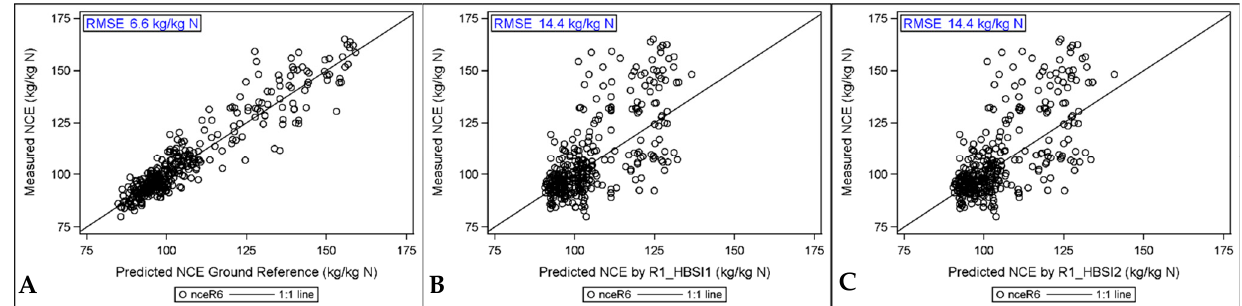
Figure 6. Predicted vs. actual (measured) estimates of NCE with RMSE for each plot. The black line is the 45° reference line (1:1 line). ( A ) Ground reference mixed model; ( B ) R1 HBSI1 model; ( C ) R1 HBSI2 model.